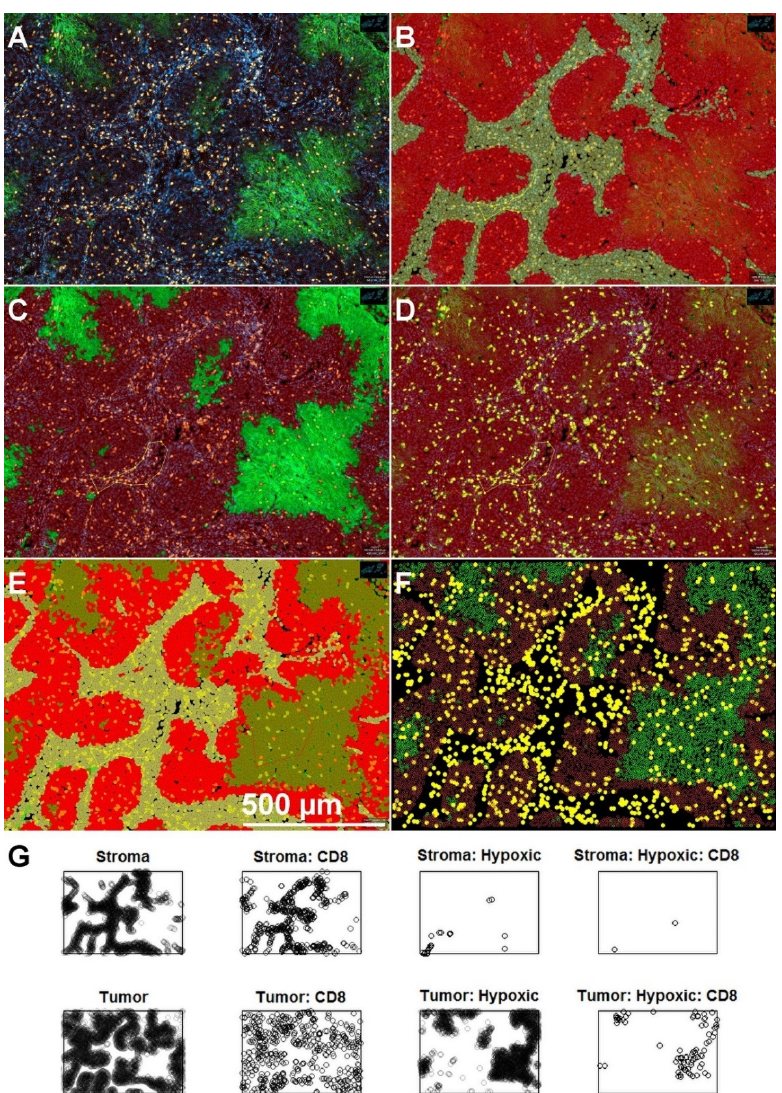
Figure 1. A representative area from a whole-slide specimen is shown to demonstrate the procedure of data acquisition in QuPath, cell classification, and transfer to R. ( A ) Tumor section after single-cell detection in QuPath. Approximated cell borders, extrapolated from the positions of cell nuclei, which had been segmented based on the DAPI channel (blue), are depicted by red lines. CD8- positive cytotoxic T lymphocytes (CTL) are shown in yellow. Hypoxic, CA IX-positive tumor cells are shown in green. ( B ) Result of the tumor-stroma classification using QuPath’s machine learning features. A set of example areas for tumor and stroma were delineated by the user. QuPath was then able to discriminate between both compartments for the rest of the cells in the specimen. ( C , D ) Construction of additional single-threshold classifiers for hypoxic cells ( C ) and CD8-positive CTL ( D ). ( E ) A compound classifier comprising tumor, stroma, and subclassifications according to the single-measurement classifiers shown in panels ( C , D ). Scale bar in ( E ) applies to panels A – E . ( F ) A color-coded plot of cell positions generated in R after transfer of the data and conversion to a multitype planar point pattern (ppp) in Spatstat. For the sake of clarity, subclassifications have been reorganized to CD8-positive CTL (yellow), normoxic tumor cells (brown), and hypoxic tumor cells (green). Original subclassifications are shown in panel ( G